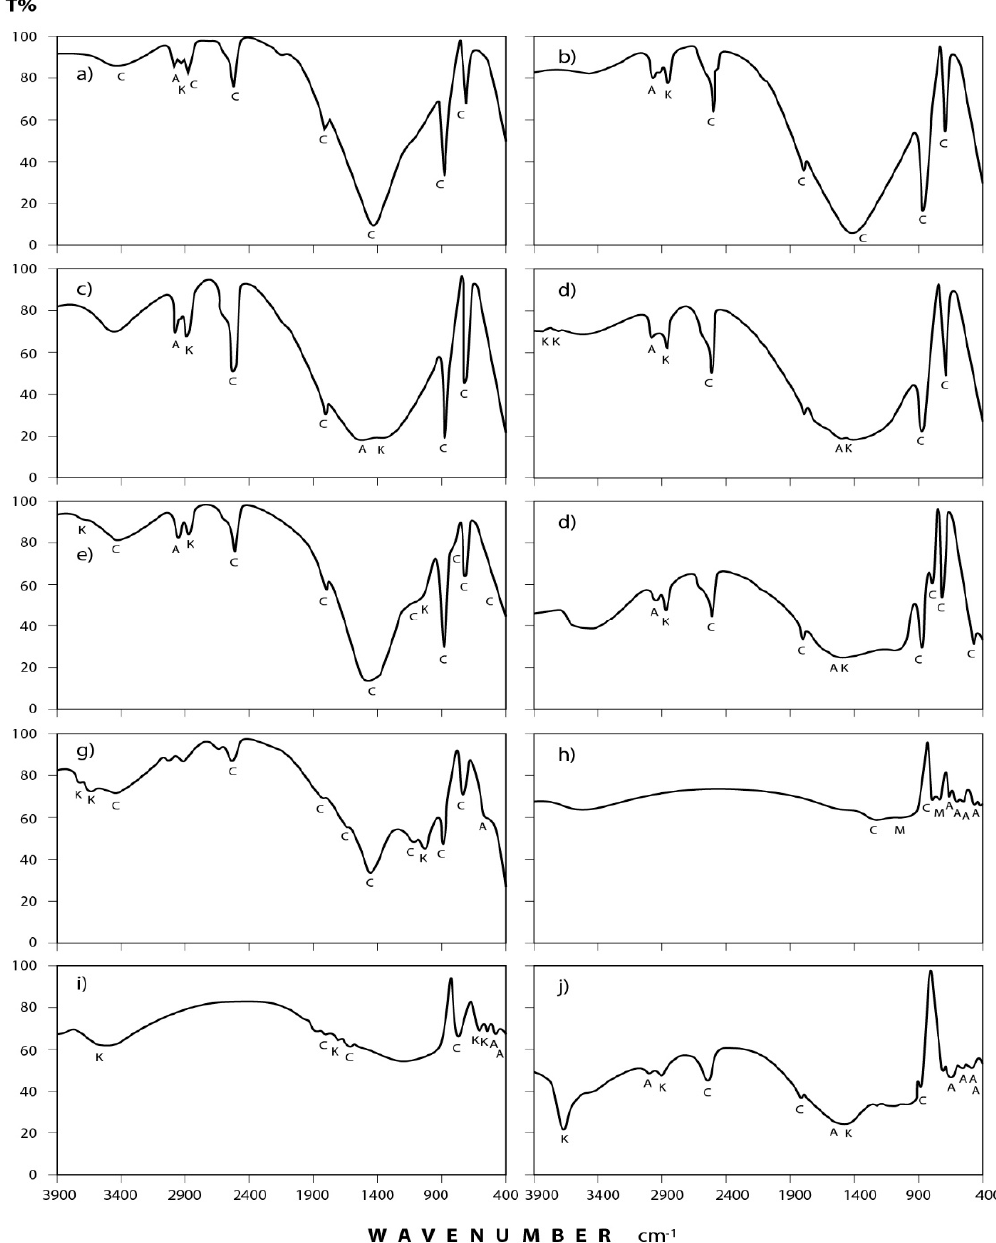
Figure 5. IR spectra of the minerals and organic species detected in stones commonly processed at Shaq El − Teeban Industral Area. ( a ) Fass Galala; ( b ) Plain Galala; ( c ) Treasta; ( d ) Local Selveia; ( e ) Golden Sinai; ( f ) limestone; ( g ) Hashmi stone; ( h ) Red Royal granite; ( i ) Gandola granite; ( j ) Indian Green marble. A = albite; AK = alkane; C = calcite; G = gypsum; K = kaolinite; M = microcline; Q = quartz.